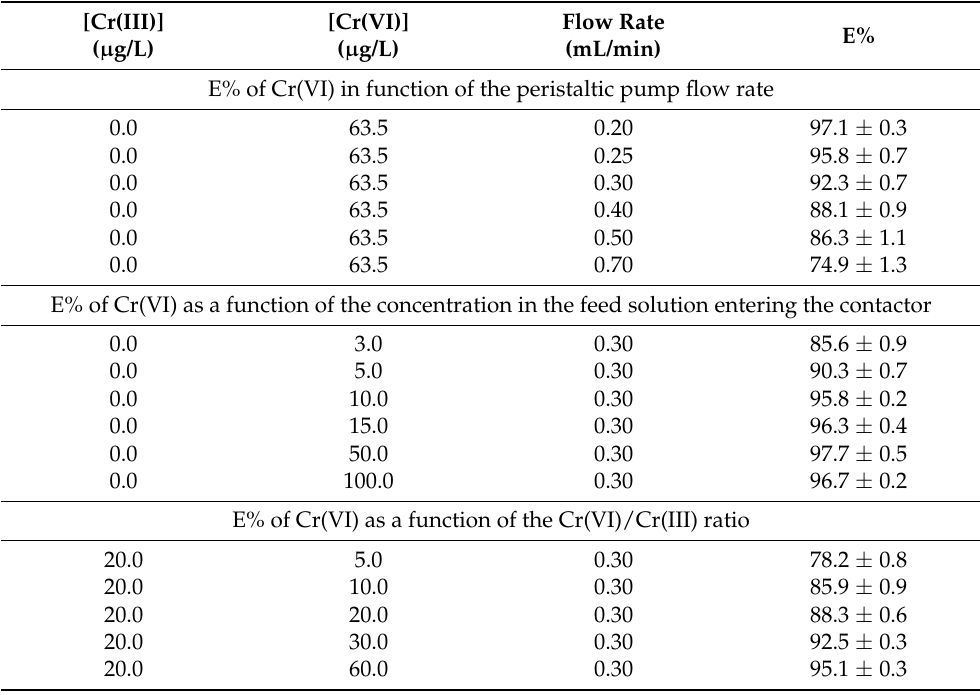
Table 2. The extraction efficiency percentage (E%) on varying the Cr(III) and Cr(VI) concentrations and the flow rate (mL/min) of the TMC in mode A (feed inside small fibers and receiving outside of large fibers), with membrane and receiving solutions on